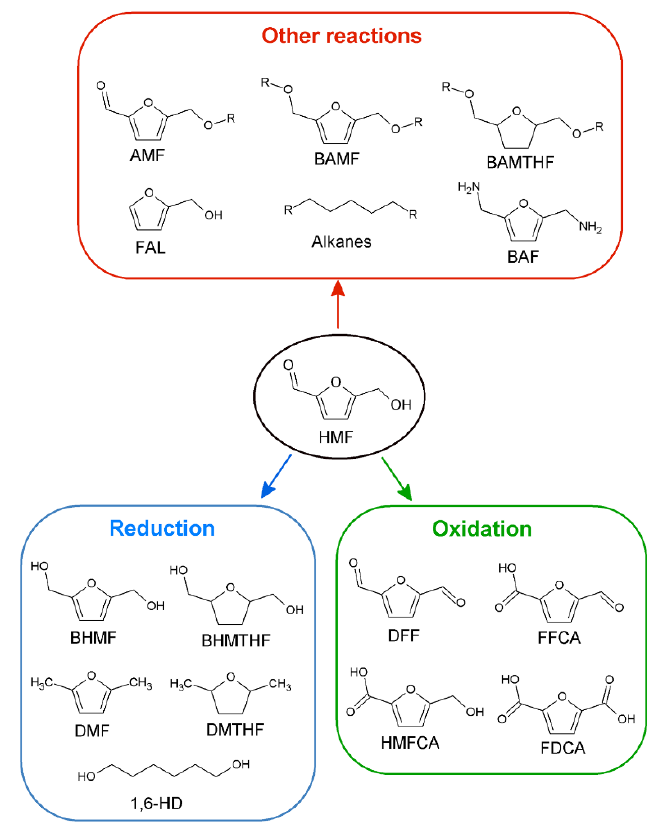
Figure 5. Possible pathways for the production of added-value bio-products from HMF.